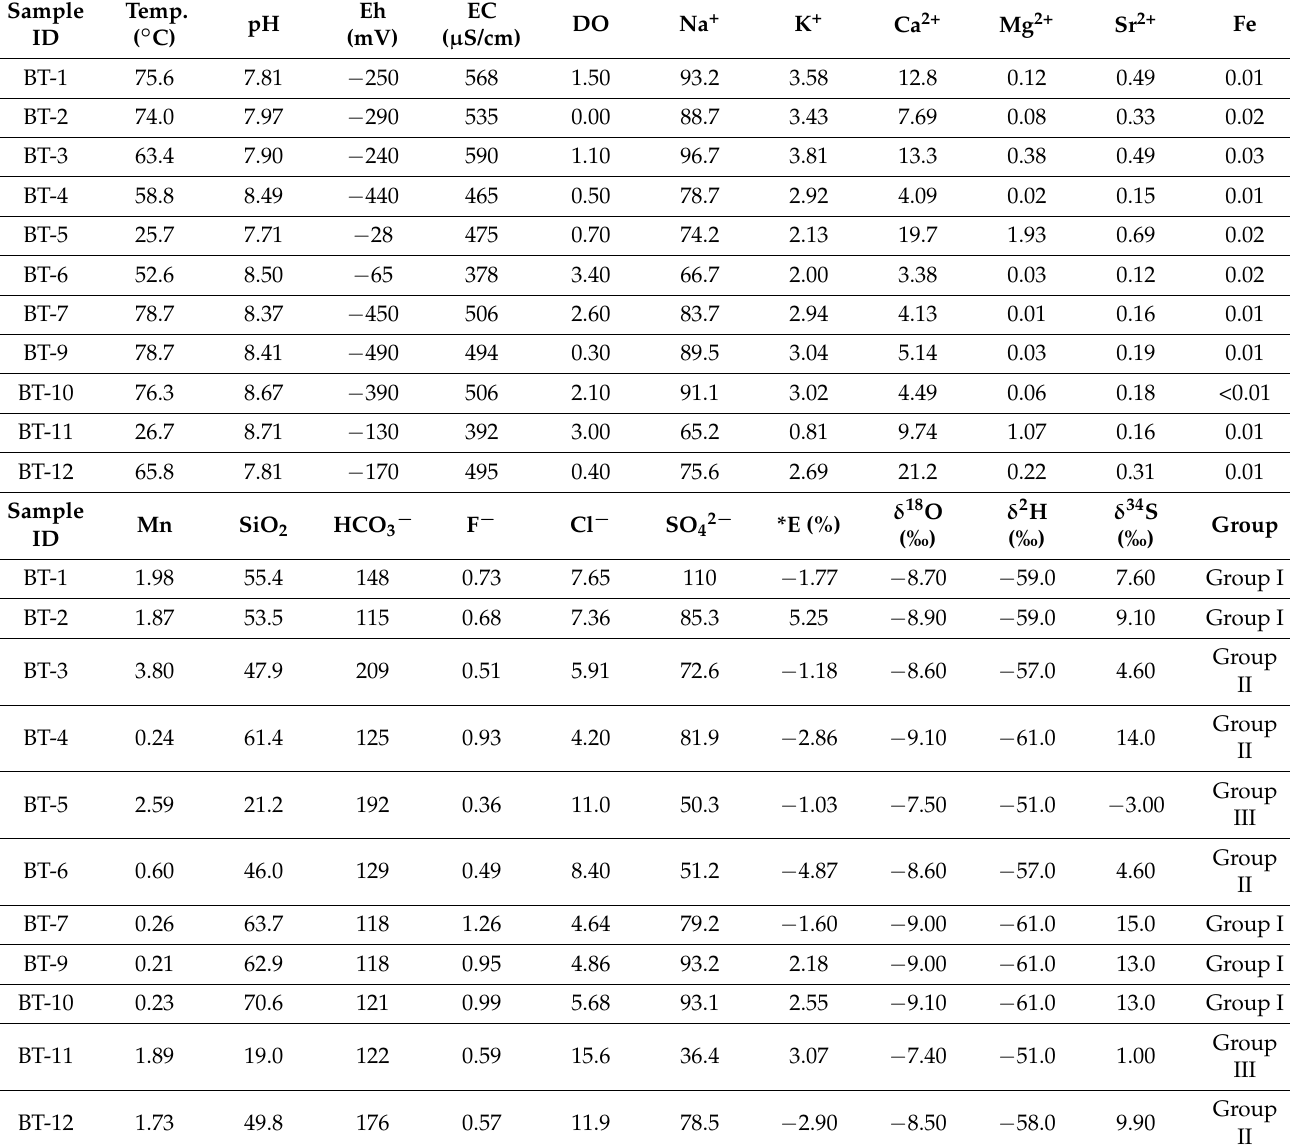
Table 1. Geochemical and isotopic composition of thermal water samples (mg/L) in the study